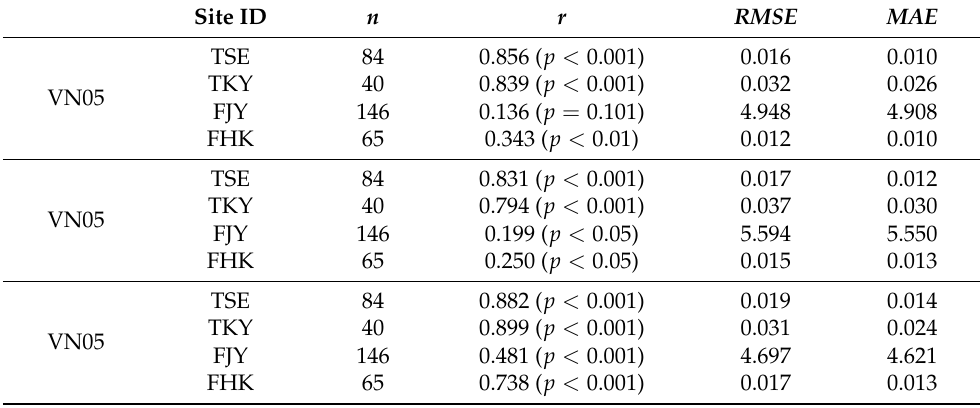
Figure A1. The scatter plots of simulated band value and satellite band value used for calculation of PRI and CCI. The shape of each point represents the year. The color of each point corresponds to the DOY. Note that the range of the x-axis and y-axis is limited from 0 to 0.1, so a few points out of the range are not displayed. Table A2. The statistics of the accuracy assessment of VN05, VN06, and